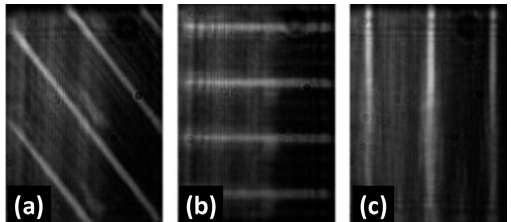
Figure 6. Rotation of the structured illumination for configuration Com 1 : three selected orientations of focal lines on the Fresnel-mirror shaped by SLM graphics software: ( a ) diagonal, ( b ) perpendicular and ( c ) parallel to the contact line of the partial mirrors of the Fresnel bi-mirror.